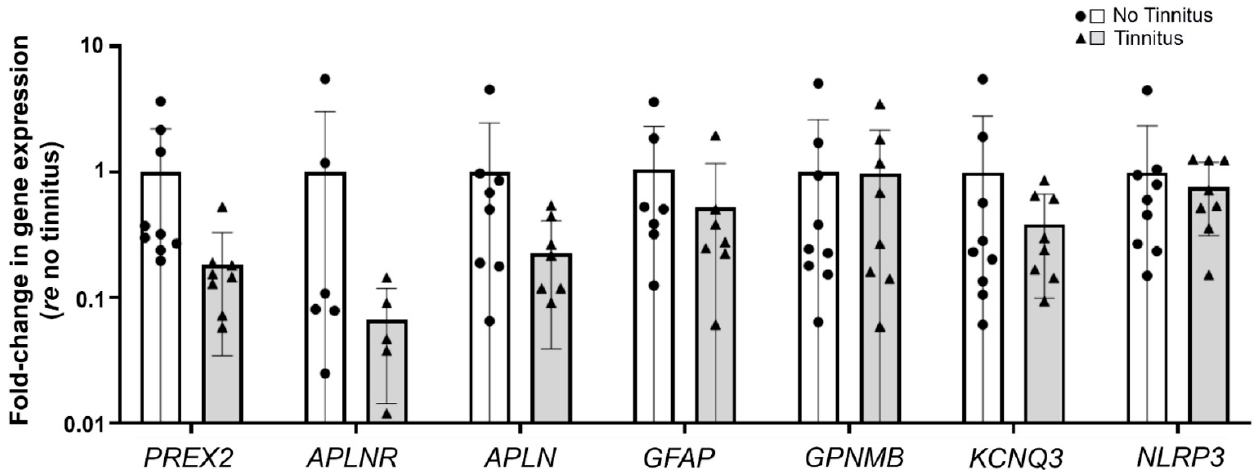
Figure 5. RT-qPCR validation of candidate genes identified via RNA-seq or implicated in previous tinnitus studies. VS tissue from patients without tinnitus (white bars, circles) was compared to VS tissue from patients with tinnitus (gray bar, triangles) (n = 19 total samples; see Table S1 for patient information). While there was a trend for lower expression of several genes in VS tissue associated with tinnitus, this trend did not meet our criterion for significance. Error bars indicate standard deviations. Abbreviations: RNA-seq, RNA sequencing; RT-qPCR, reverse transcription–quantita- tive polymerase chain reaction.